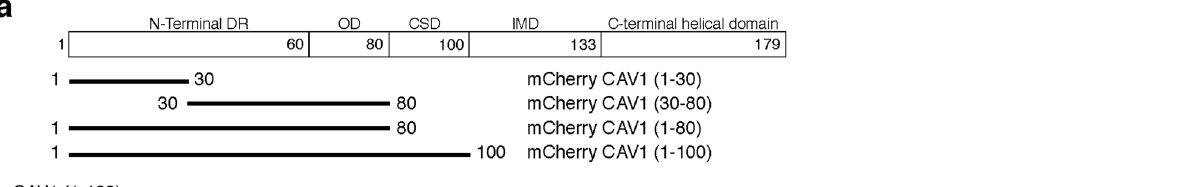
Fig. 3 CAV1 N-terminus co-phase separates with Cavin1. a Schematic representation of CAV1 domain architecture and design of various domain/point mutations. LLPS assays with MBP-GBP-CAV1 and cavin1 independently ( b ) and in mixture ( c ). MBP – GBP – CAV1 does not undergo LLPS in isolation but co- phase separates with Cavin1. d LLPS assays with different CAV1 DR region mutations and GFP-Cavin1 or Cavin1 – DR3 or Cavin1 – DR1. Scale bar — 10 μ m. Among all truncation mutations tested, only mCherry-CAV1 (1 – 100) was able to co-phase separate with Cavin1. Among CAV1 DR point mutations (M1 – M5), mutants M1, M2 and M4 were able to co-phase separate with GFP-Cavin1 while total charge inversion mutant M3 and mutant M5 failed to co- phase separate highlighting the importance of charged residues in CAV1 – Cavin1 association. Scale bars = 10 μ m; enlarged boxes scale bar = 5 μ m.